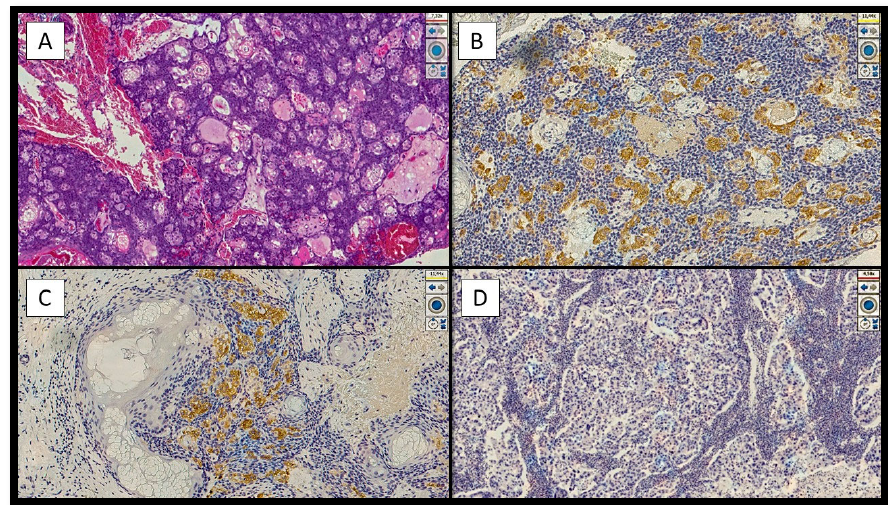
Figure 1. Examples of positivity and/or negativity for immunostaining of PRAME in the cases ana- lyzed in this study. ( A ) Histological micrograph showing a sebaceous carcinoma of grade I in order to World Health Organization Skin Tumor Classification 2018, characterized by numerous foci of sebaceous differentiation (Hematoxylin-Eosin, Original Magnification 4 × ). ( B ) Immunohistochemical preparation with antibody anti-PRAME that shows the sebaceous cells positive with an immunoscore of intensity of 3+/4+ and a high percentage cells positivity of 2+/3+ (Immunohistochemical for PRAME, Original Magnification 4 × ). ( C ) Details of the previous histological picture showing the sebaceous cells positive for PRAME in a neoplastic aggregate of sebaceous carcinoma (Immuno- histochemistry for PRAME, Original Magnification 10 × ). ( D ) Example of immunohistochemical preparation nearly totally negative, or only focal positive, for PRAME (Immunohistochemistry for PRAME, Original Magnification 10 ×